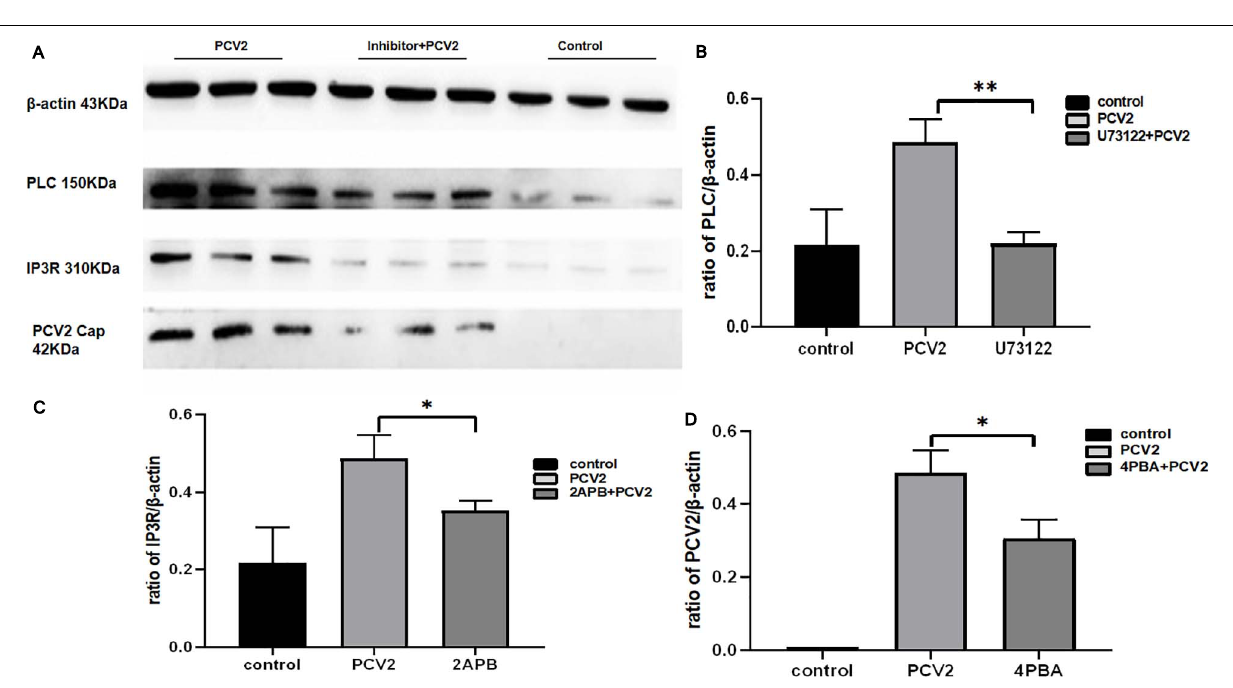
FIGURE 5 | Expression of different proteins after inhibitor addition changes of the control group. (A) Western blot results. (B) Histogram of PLC protein expression in different experimental groups after the addition of U73122 showed that the PLC expression in the virus infection group with inhibitor was significantly different from the inhibitor group. (C) Histogram of IP3R protein expression in different experimental groups after the addition of 2-APB. (D) The histogram of PCV2 Cap protein expression in different experimental groups after the addition of 4-PBA showed that the expression of PCV2 Cap protein in host cells significantly decreased after the addition of 4-PBA. “*” represents difference, 0.01 < p < 0.05; “**” represents very significant difference, p <